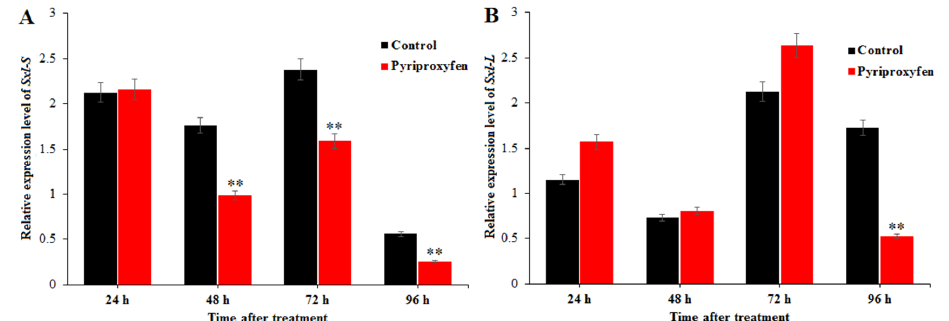
Figure 5. The effect of pyriproxyfen exposure on the expression levels of genes related to sex differentiation: ( a ) Sxl-S and ( b ) Sxl-L . The black histogram represents the control group, and the red histogram represents the treatment group. The x -axis represents the time after pyriproxyfen exposure, and the y -axis represents the relative expression level of genes. The results are shown as the mean ± SE. Asterisks denote significant differences between treatments and controls, as indicated by * p ≤ 0.05 and ** p ≤ 0.01.